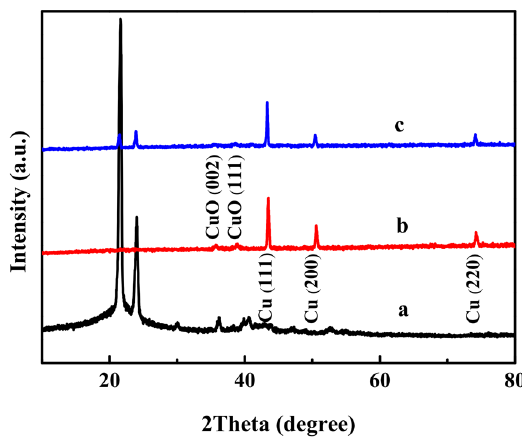
Figure 2. XRD patterns of pure paraffin (a), PDMS-OCF (b) and PDMS-OCF /paraffin composite (c)